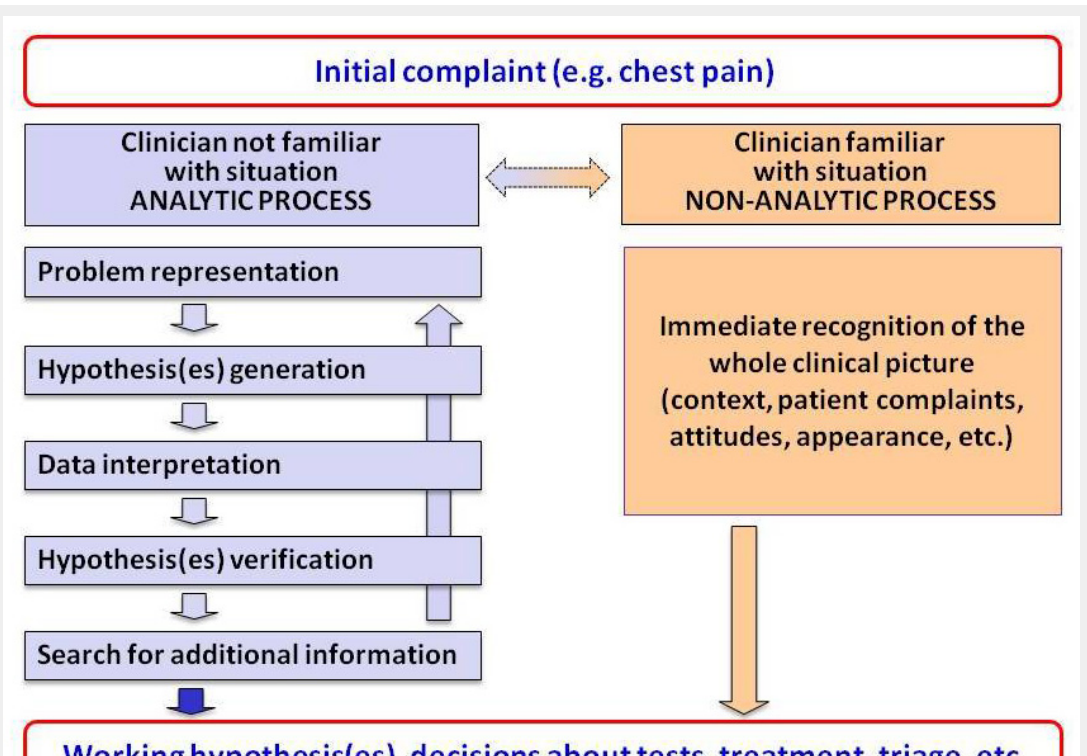
Schematic representation of the dual process of reasoning including immediate recognition of clinical picture (non-analytic process, right boxes) and hypothetico-deductive process (analytic process, left boxes). There is a high level of interaction between both processes in practice. A similar figure has been published in: Nendaz M. Éducation et qualité de la décision médicale: un lien fondé sur des preuves existe-t-il? La Revue de Médecine Interne 2011;32(7):436–442 [6]. Copyright © 2010, Société nationale française de médecine interne (SNFMI). Published by Elsevier Masson SAS. All rights reserved. Reprinted with